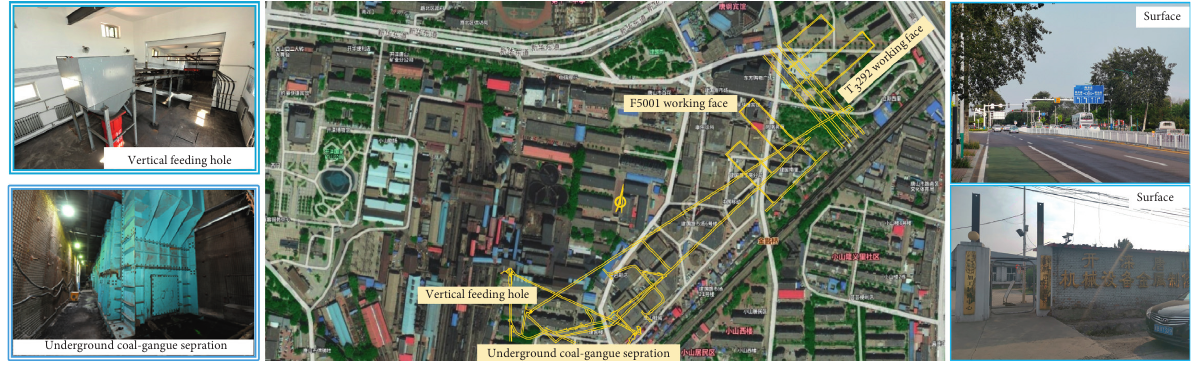
Figure 2: Tangshan mine surface-subsurface